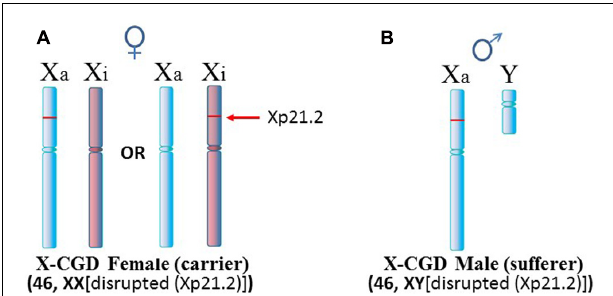
FIGURE 4 | X-linked chronic granulomatous disease (X-CGD). (A) X-CGD females are carriers of this recessive disease which is attributed to a variety of abnormalities in the CYBB gene at Xp21.2. However, in approximately half the cells, normal CYBB would be expressed from the Xa. (B) X-CGD males do not have a normal CYBB gene and usually succumb to persistent infections at an early age since they cannot clear pathogens properly.